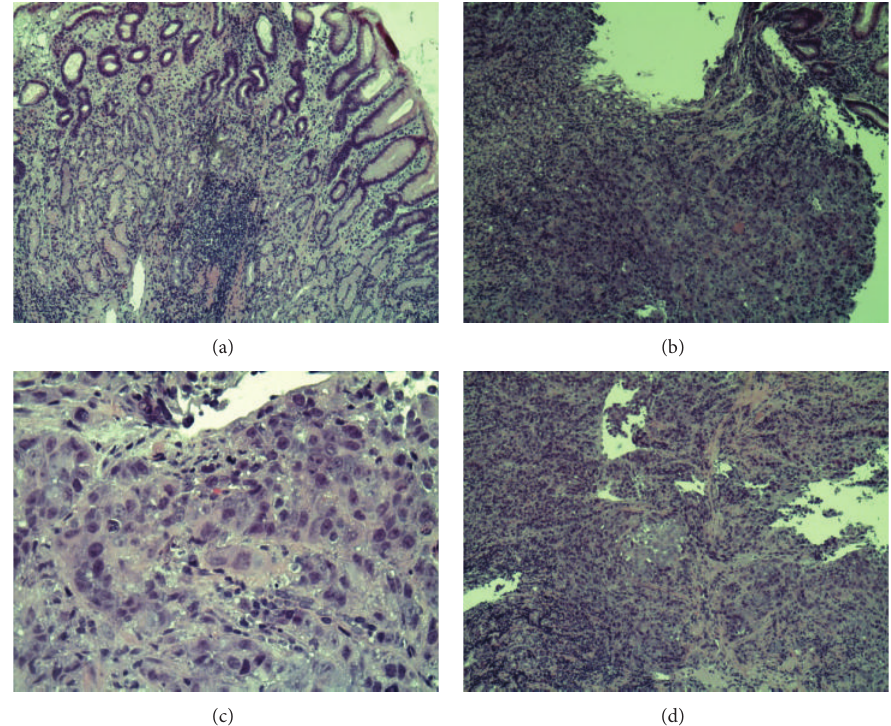
Figure 4: Histopathology of gastric cells. (a) Shows normal gastric cells consisting of mucous cells, parietal cells, and chief cells. (b), (c), and (d) Show undifferentiated adenocarcinoma gastric tumor cells.